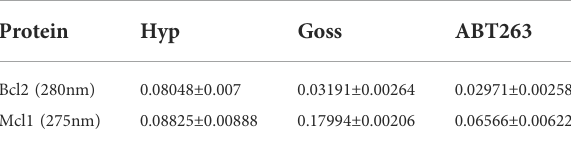
TABLE 3 The Stern-Volmer constants for Bcl2 and Mcl1 proteins with Hyp, Gossypol, and